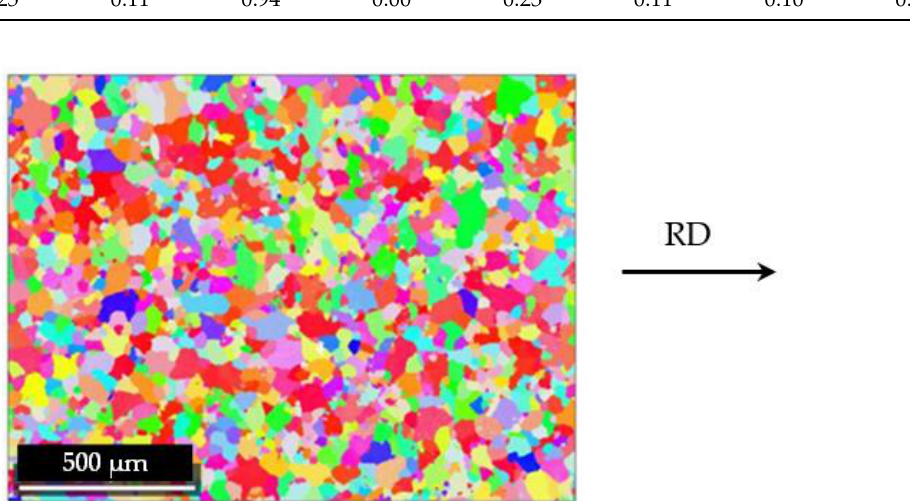
Figure 1. EBSD orientation map of the initial material.